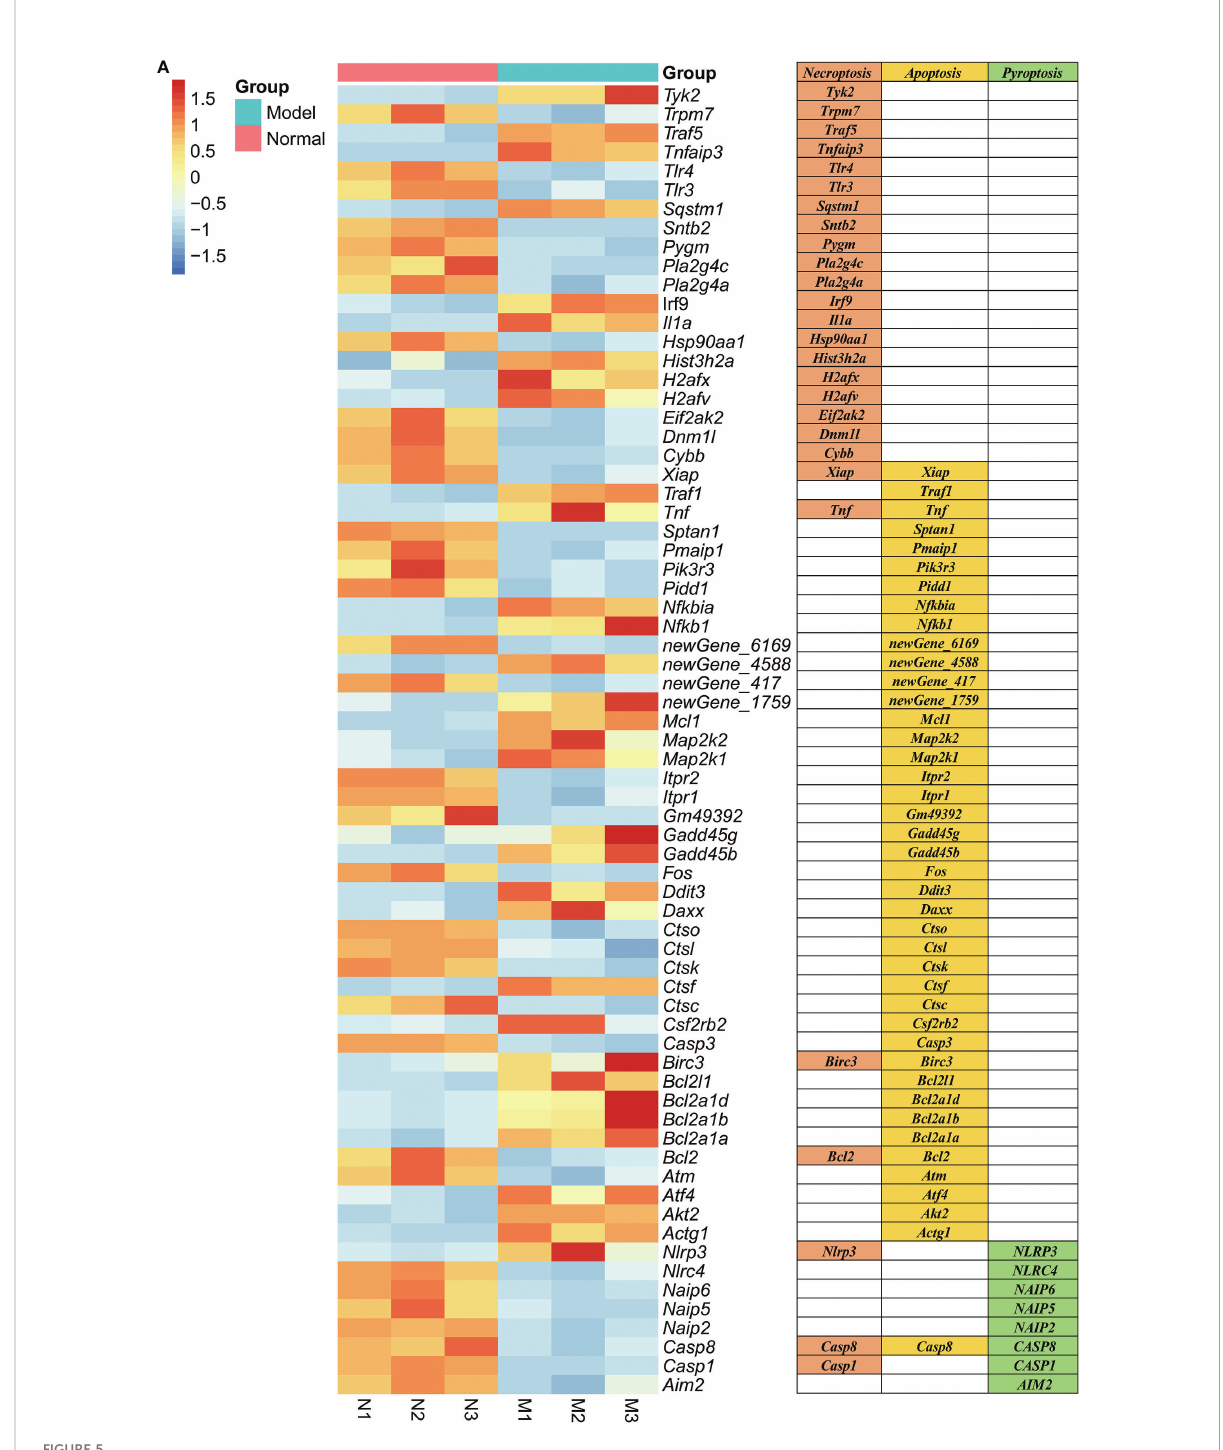
FIGURE 5 Genes related to PANoptosis were screened from differentially expressed genes in the transcriptome of RAW264.7 co-cultured with K. pintolopesii . (A) Heatmap of differentially expressed genes related to